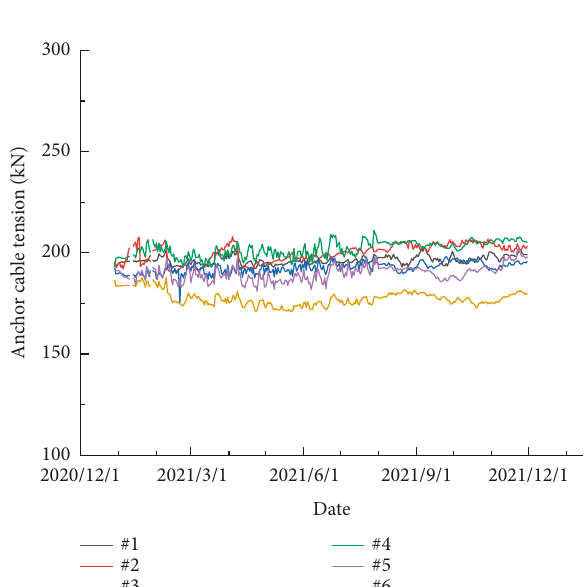
Figure 13: Schematic diagram of stress monitoring points.